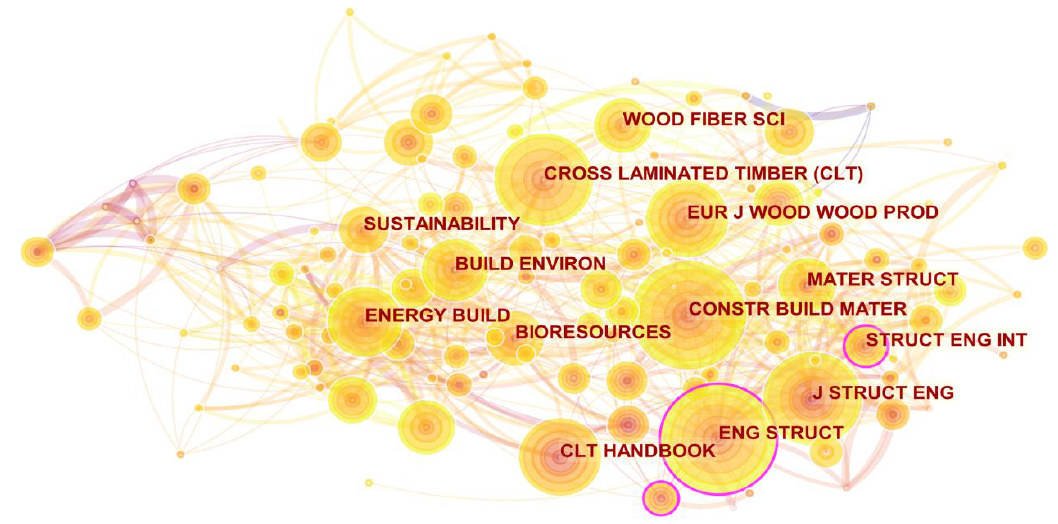
Figure 10. Journal co-citation network map related to cross-laminated timber in construction.